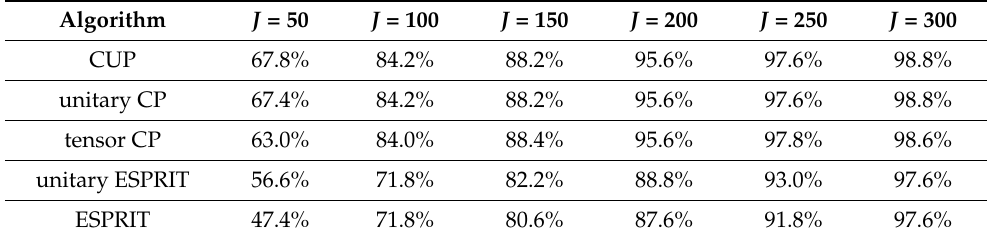
Figure 12. PSD of angle estimation versus Snapshots. Table 9. PSD of angle estimation versus